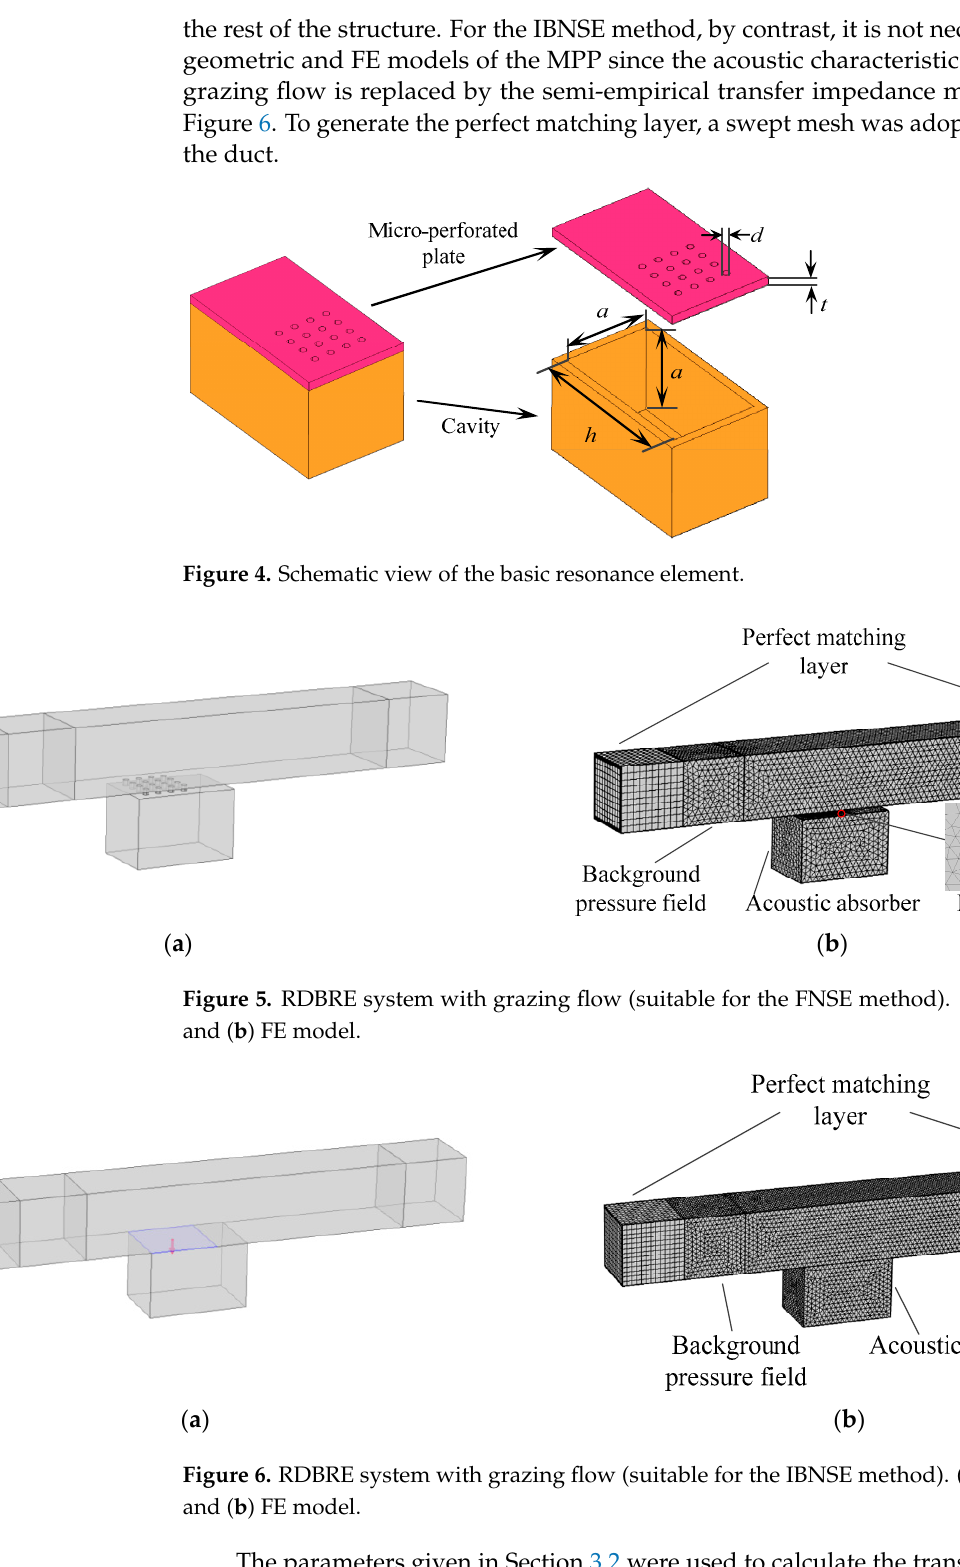
Figure 4. Schematic view of the basic resonance element.